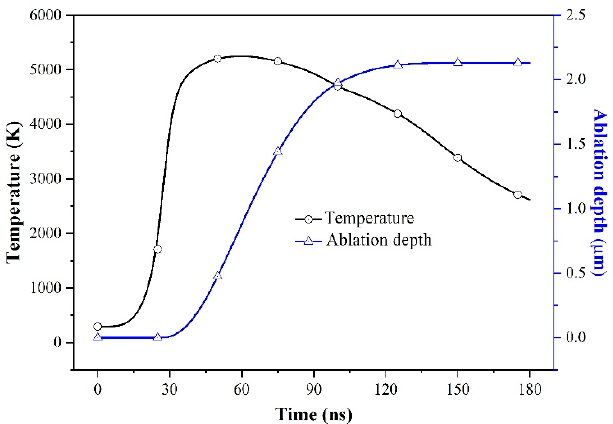
Figure 4. Variation of simulated temperature and ablation depth of laser spot center with time for laser fluence of 19.3 J/cm 2.